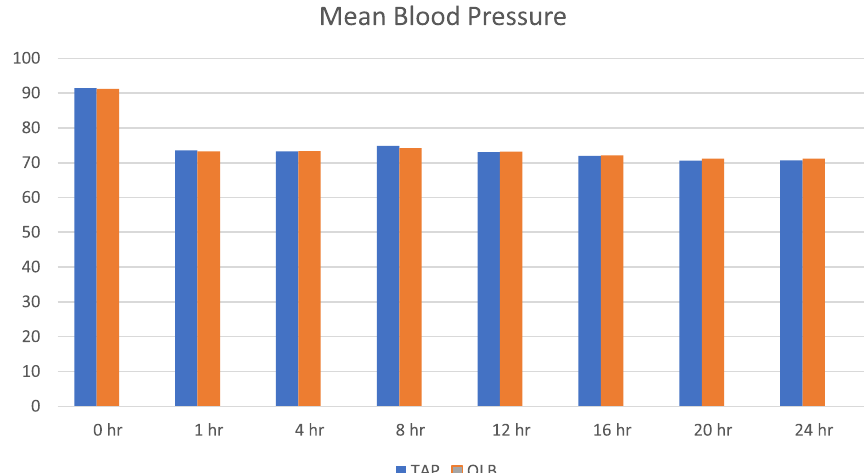
Fig. 2 Difference between TAP group and QLB group regarding MBP. X ‑axis for MBP and mmHg for the numbers written, Y ‑axis for time. Data expressed as mean SD or number and p ‑value. TAP, transverses abdominis plane block; QLB , quadratus lumborum plane block; MBP , mean blood ± pressure, p ‑value > 0.05 is considered non‑significant